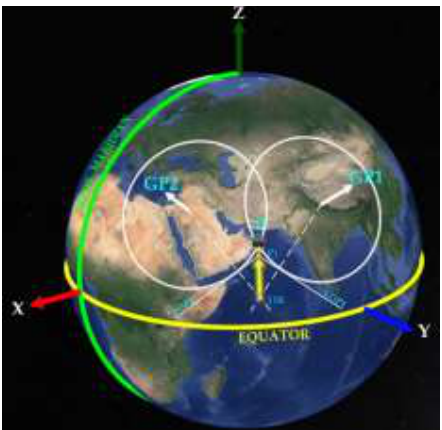
Figure 3. The conceptual basis of Newton’s method.